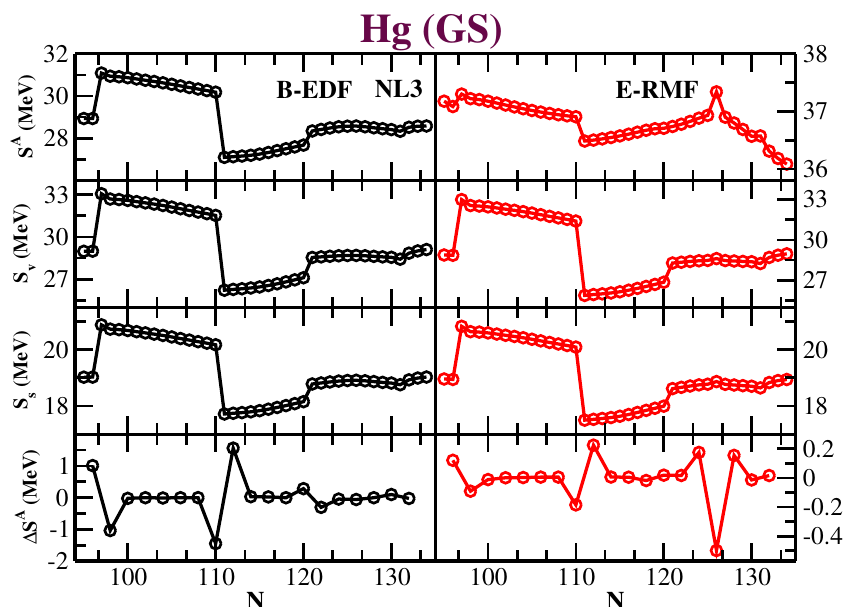
Figure 6. (Color online) The total symmetry energy ( S A ) and its shift within the Brückner functional and the Relativistic energy density functional used to obtain the volume S V and surface S S symmetry energies with Danielwiz’s prescription are shown for the ground state of Hg-isotopes using RMF (NL3) parameter set.